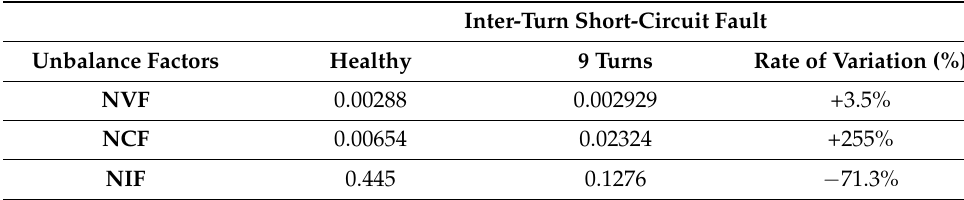
Figure 11. The defined factors for both healthy conditions and nine turns in short-circuit. Table 4. Effect of the ITSCF on the defined unbalance